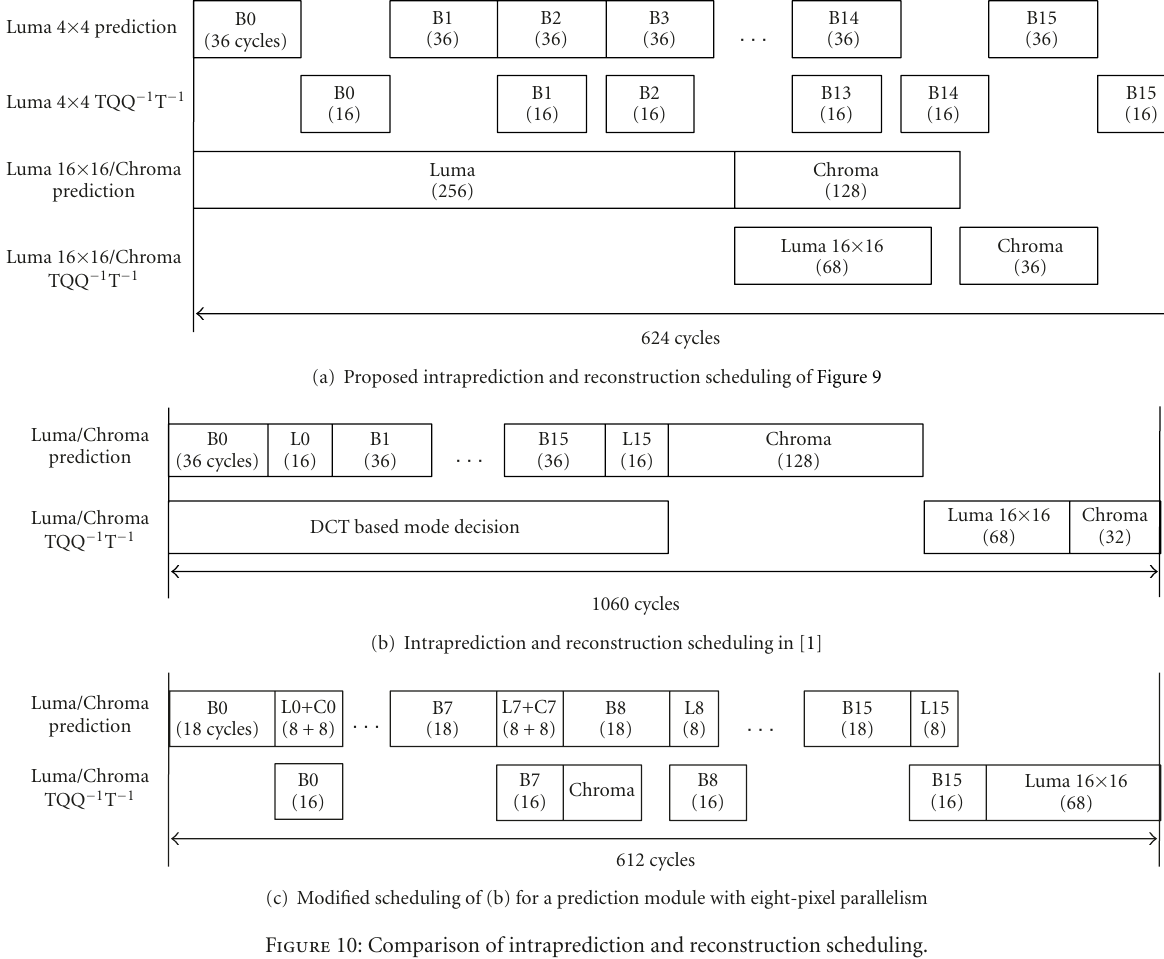
Figure 10: Comparison of intraprediction and reconstruction